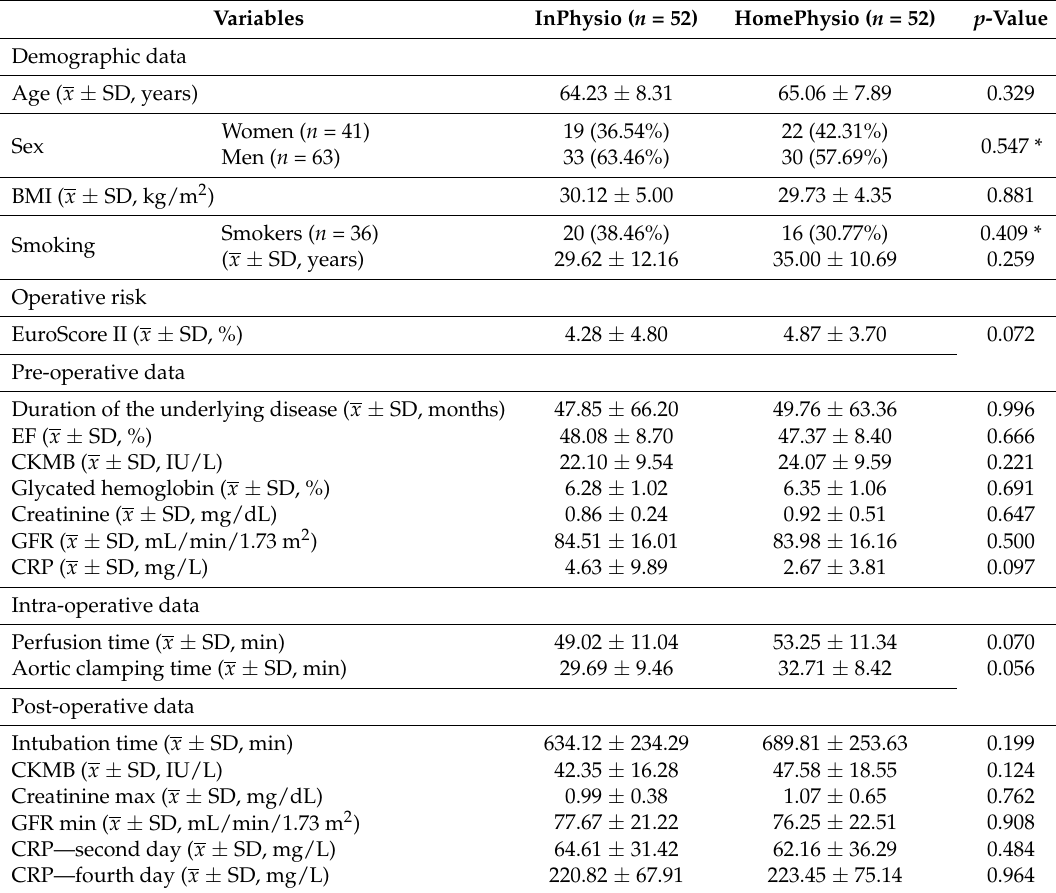
Table 1. Characteristics of selected pre-, intra- and post-operative parameters in both groups.